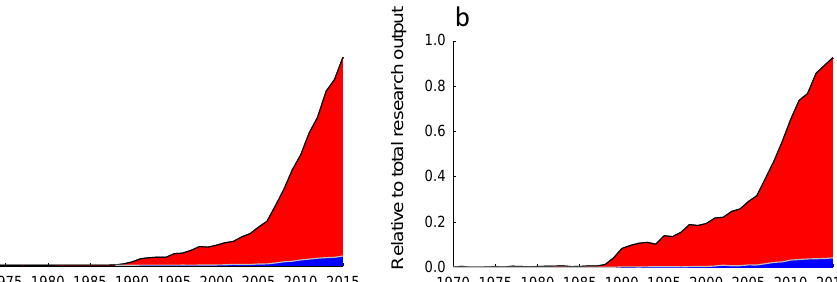
R 1970 1975 1980 1985 1990 1995 2000 2005 2010 2015 1970 1975 1980 1985 1990 1995 2000 2005 2010 2015